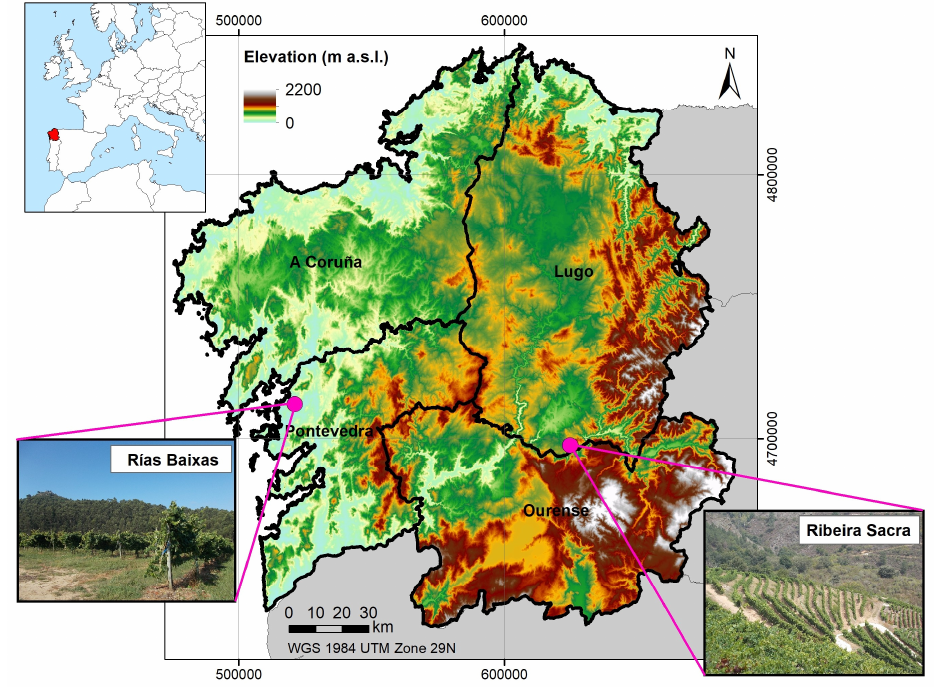
Figure 1. Location of the experimental vineyards within Galicia (North West Spain).